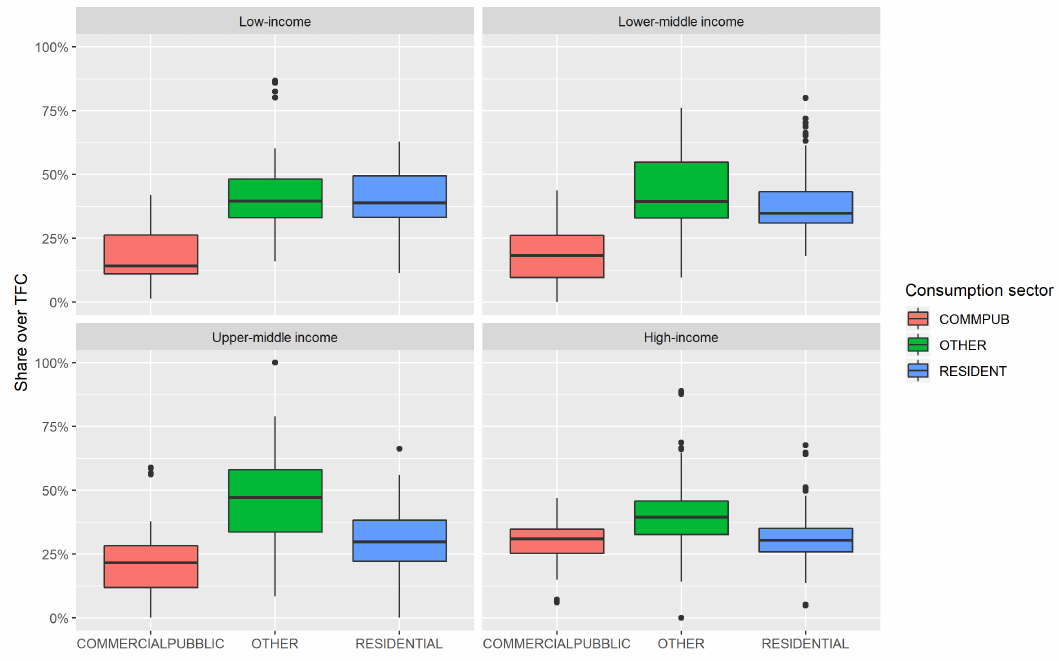
Figure 5. Share of electricity consumption sectors over TFC, by income category. Commercial and public electricity consumption (COMMPUB), residential electricity consumption